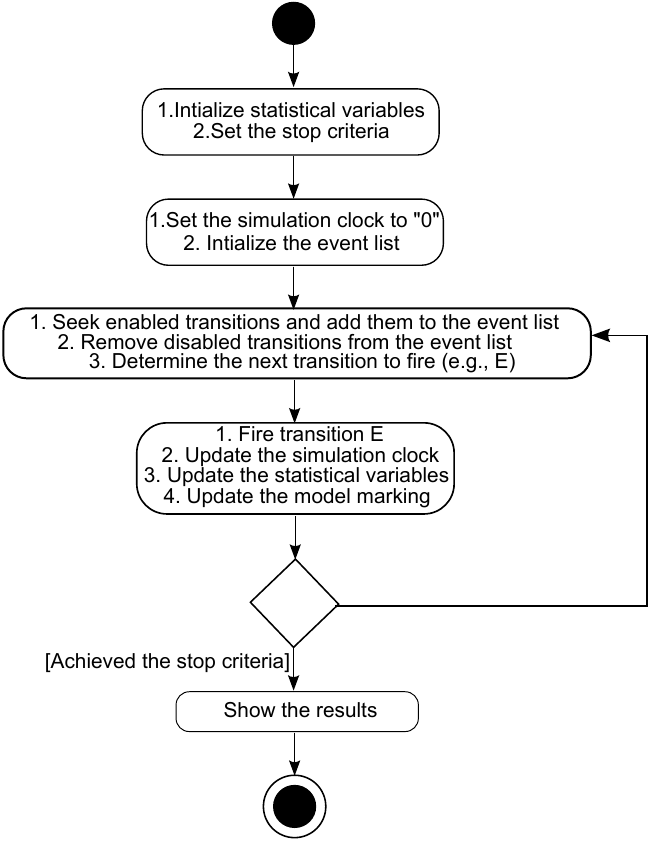
Figure 10. Mercury: simulation